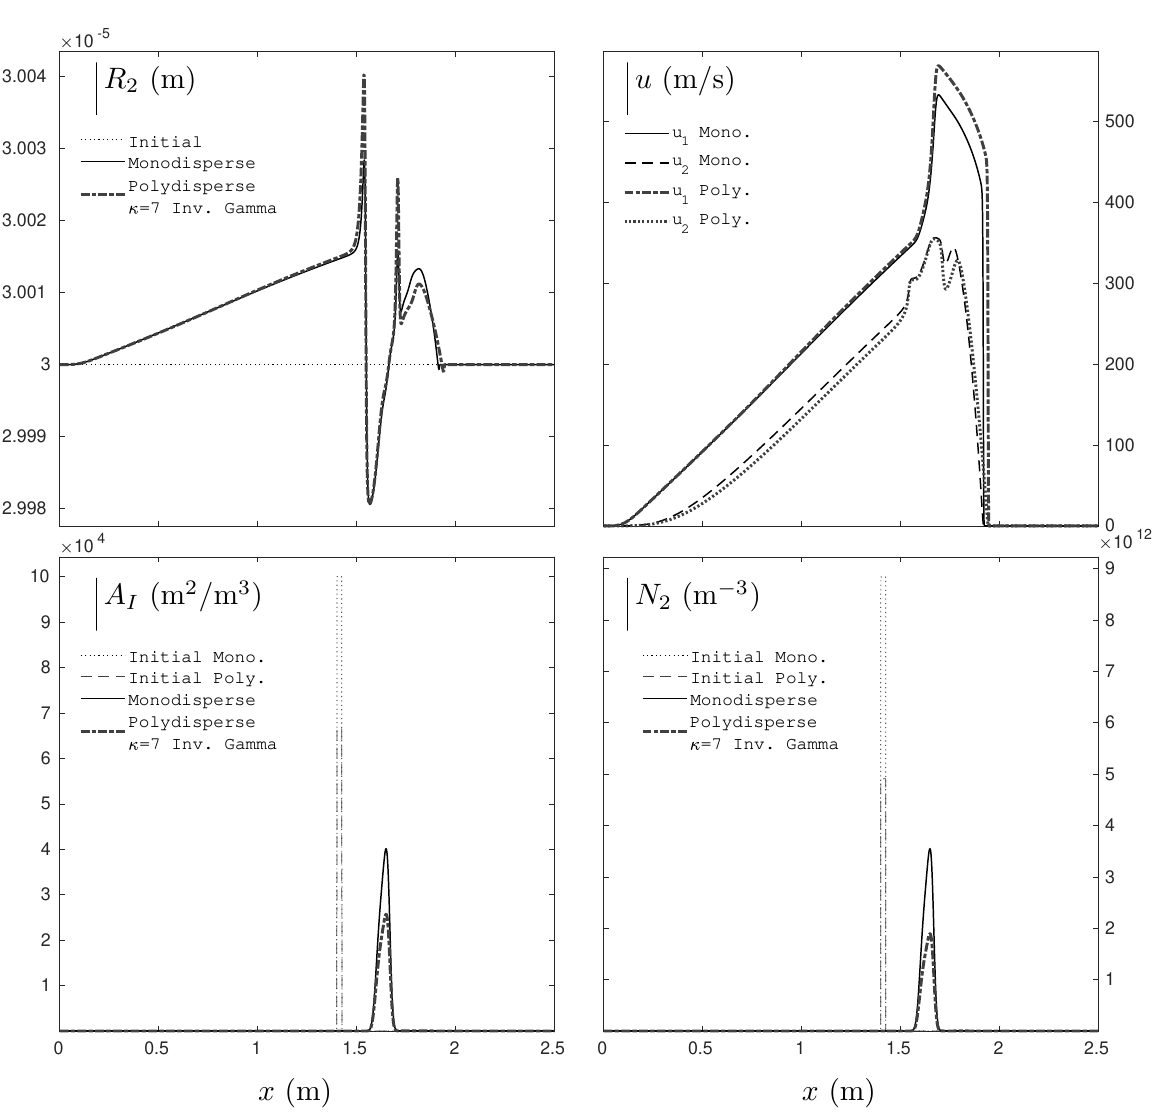
Figure 17: Simplified two-phase explosion test depicted in Fig. 5. Comparison of the monosdisperse and polydisperse results. Figure 17. Simplified two-phase explosion test depicted in Figure 5. Comparison of the monodisperse The initial mean radius is the same for both computations R 2 t =0 = R t =0 = 30 µ m. For the polydisperse computation, the t = 0 = R t = 0 2 = and polydisperse results. The initial mean radius is the same for both computations R 2 2 Inverse Gamma distribution is used with κ = 7. All results are given at time t = 1 . 2 ms and are presented in terms of A I , u , 30 µ m. For the polydisperse computation, the Inverse Gamma distribution is used with κ = 7. N 2 and R 2 for both computations. Differences between the two solutions are visible. All results are given at time t = 1.2 ms and are presented in terms of A I , u , N 2 and R 2 for both computations. Differences between the two solutions are